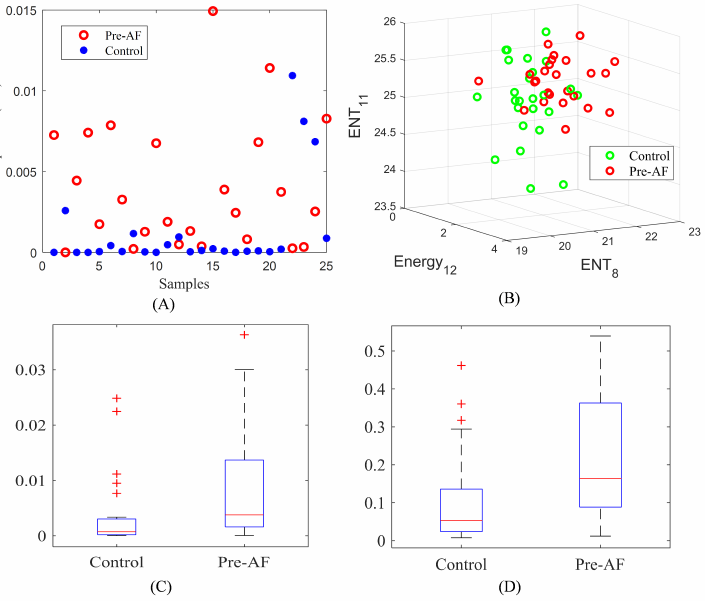
Figure 7. ( A ) VFCDM feature. ( B ) 3D scatter plot of spectral entropy (level 8, 11) and energy of level 12. ( C ) Box plots of RMSSD. ( D ) Box plots of AR residual noise.